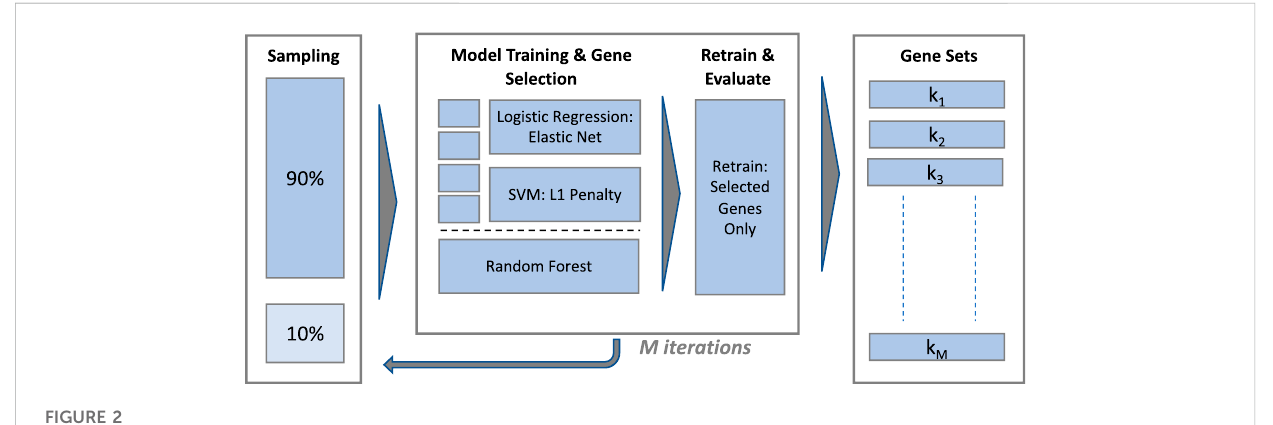
FIGURE 2 Gene selection performance and stability